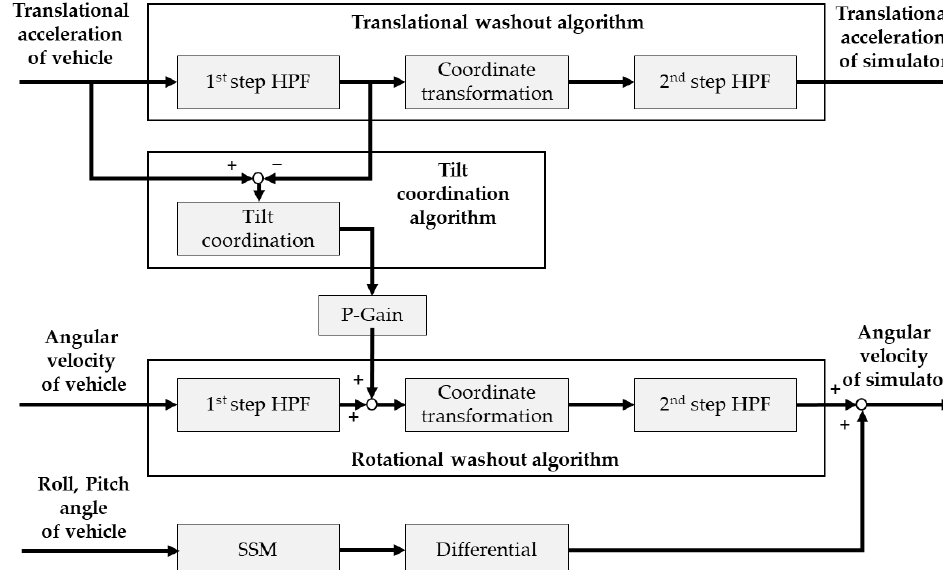
Figure 2. Structure of the proposed washout algorithm.